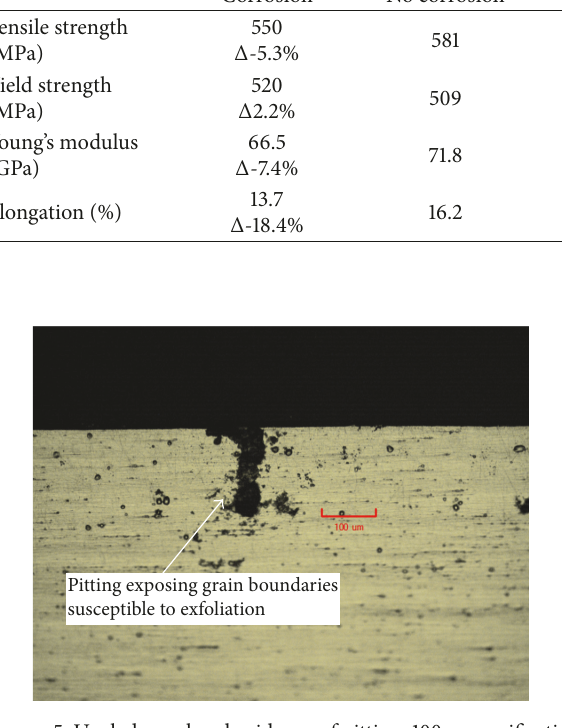
Figure 5: Unclad panel and evidence of pitting, 100x magnification and 100-micron